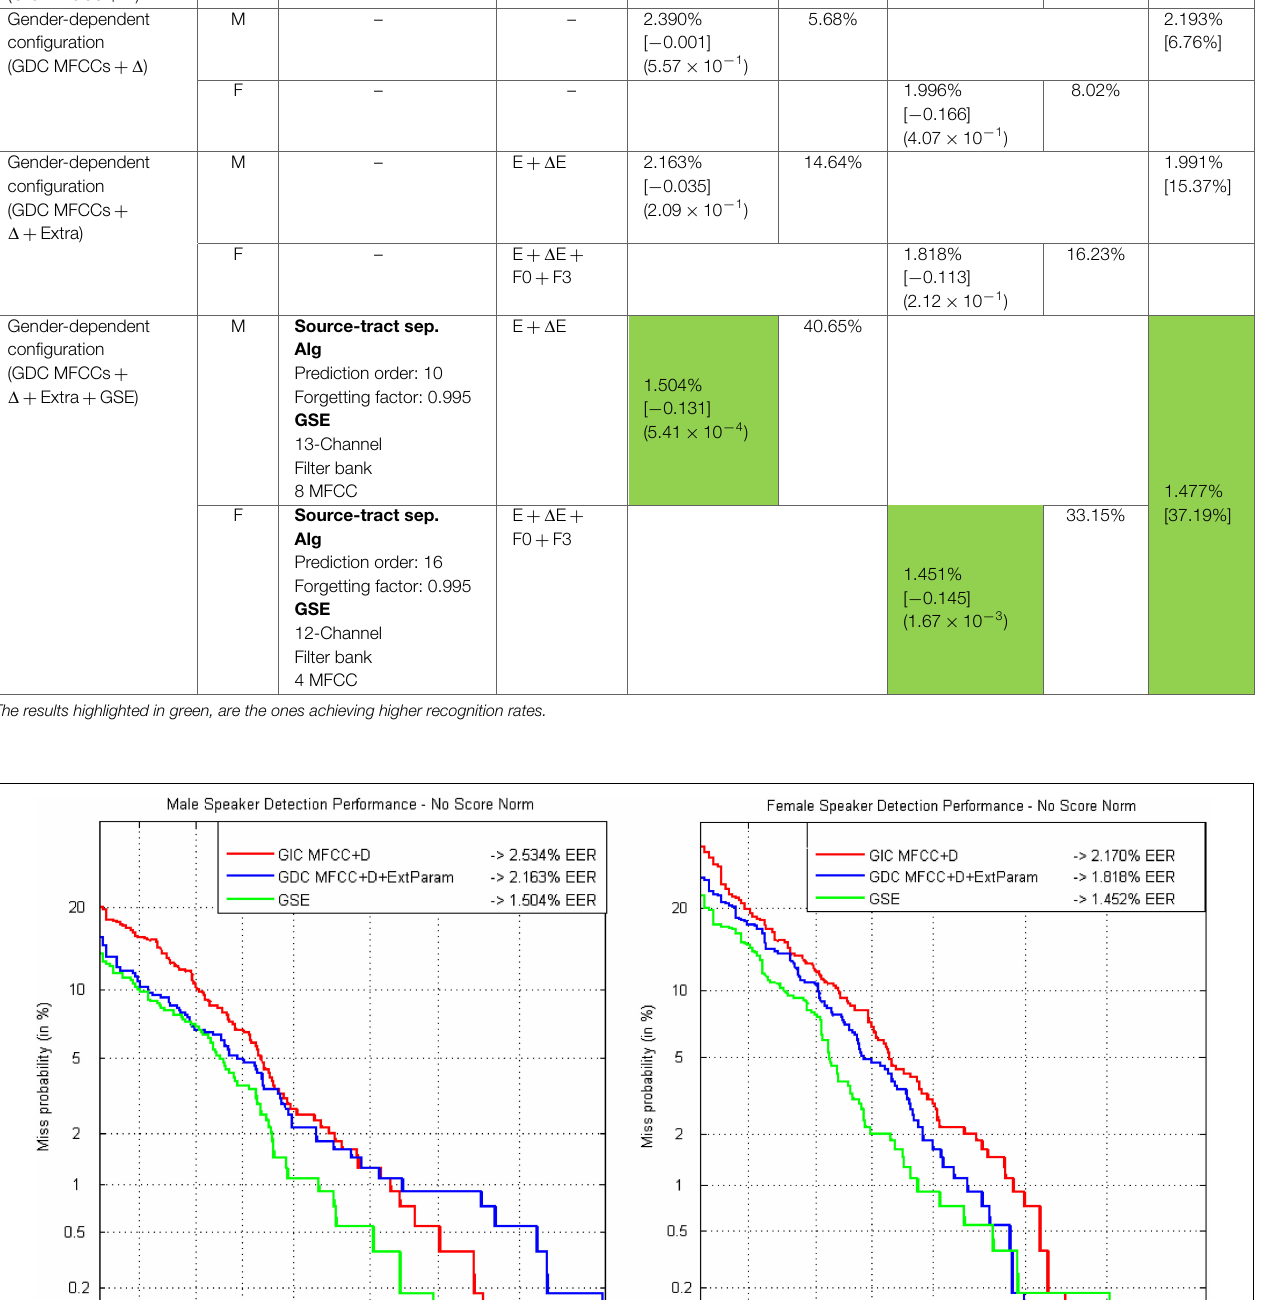
Frontiers in Bioengineering and Biotechnology |